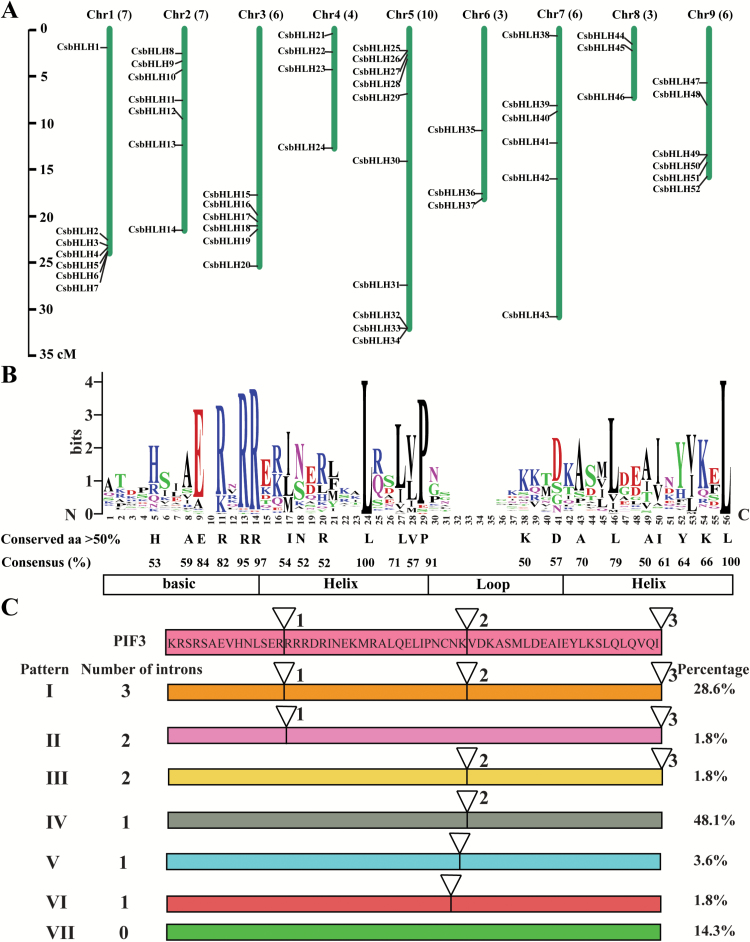
Chromosomal distribution, sequence logos, and intron number within the bHLH domains of CsbHLH genes. (A) Chromosomal distributions of CsbHLH genes. The chromosomal positions of CsbHLH genes are mapped according to the sweet orange genome and named from CsbHLH1 to CsbHLH52 based on their order in the nine chromosomes. The chromosome numbers are indicated on the top of each chromosome. (B) Sequence logos of the bHLH domains. The overall height of the stack indicates the sequence conservation of the corresponding amino acid. The upper case letters below the logo indicate >50% consensus amino acids among all CsbHLH domains. (C) Intron distribution patterns, designated as Type I–VII, within the conserved bHLH domain of CsbHLH genes. Intron positions are marked with inverted triangles and numbered (1–3) based on the reference gene PIF3 from A. thaliana. The number and percentage of genes in each category are shown on either side of the intron patterns. (This figure is available in colour at JXB online.)